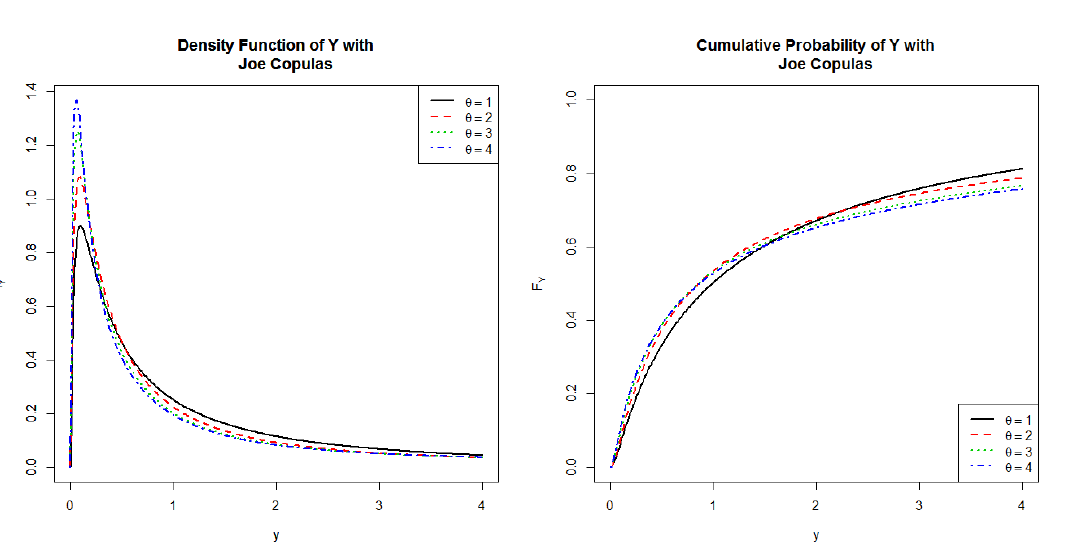
Figure 6. PDFs and CDFs of the product of two log-normal distributed random variables having Joe